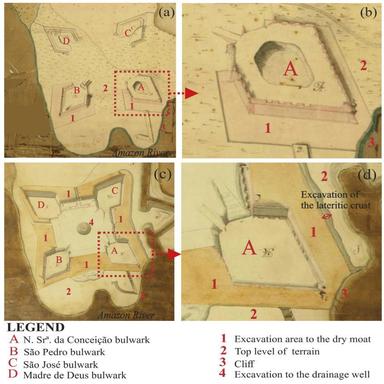
Minerals identified by XRD for an FLC sample from the lateritic profile next to FSJM (SJ.R.05/13 sample).